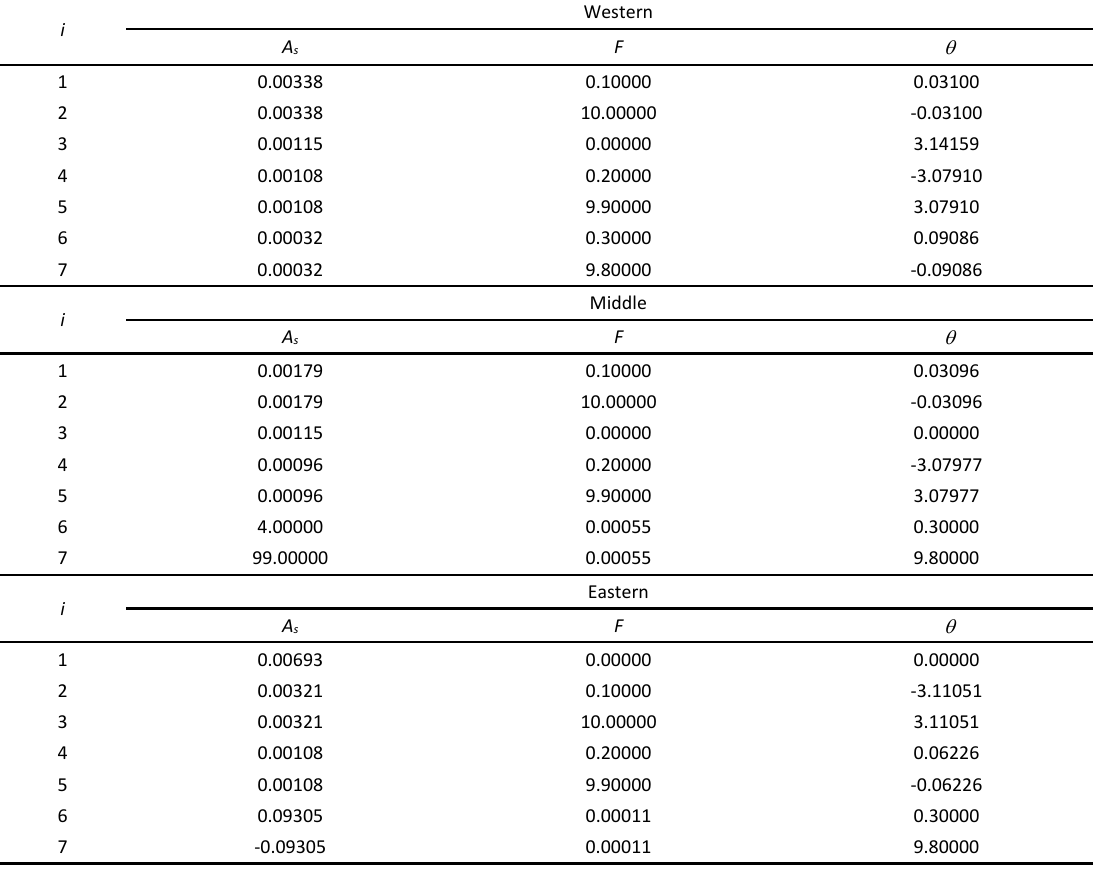
Table 2: Amplitude, frequency, and phase of sea level values